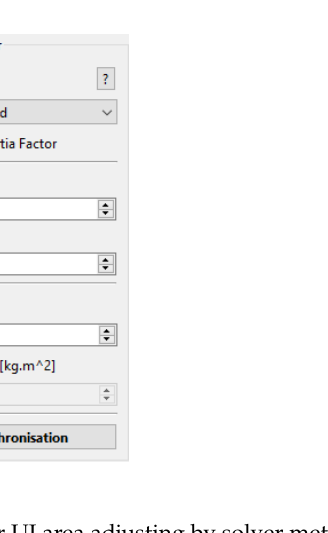
Figure 20. Solver UI area adjusting by solver method: ( a ) solver area for the time-domain method